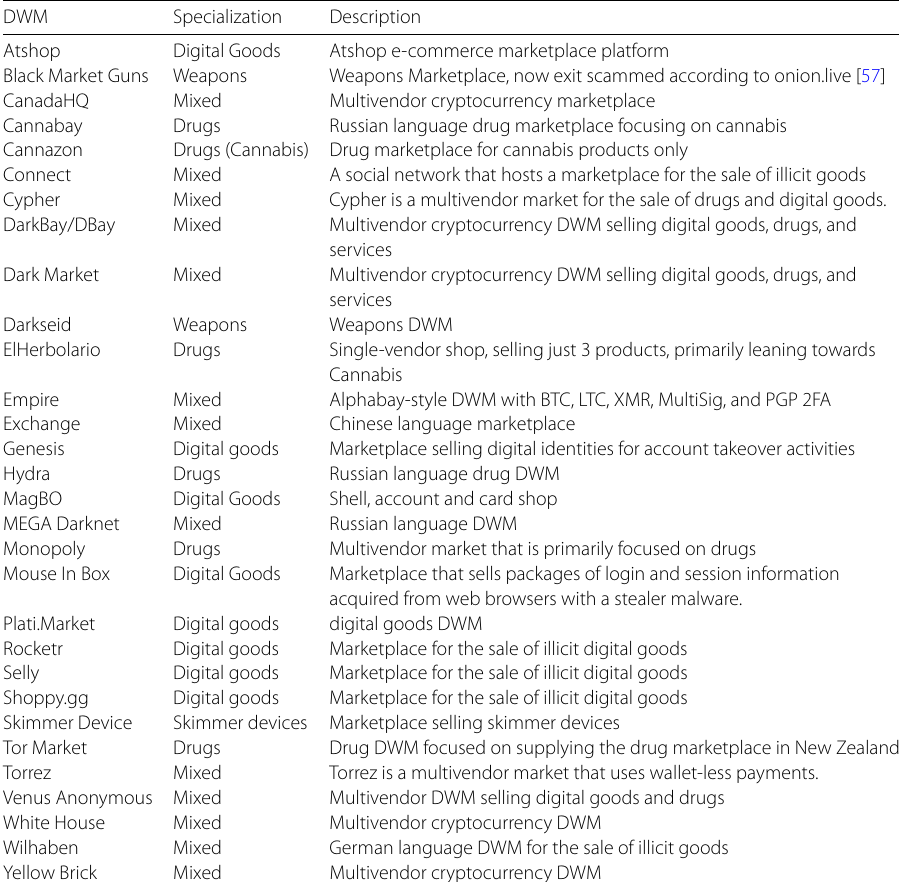
Table 7 List of all DWMs, together with their specialization and a brief description DWM Specialization Atshop